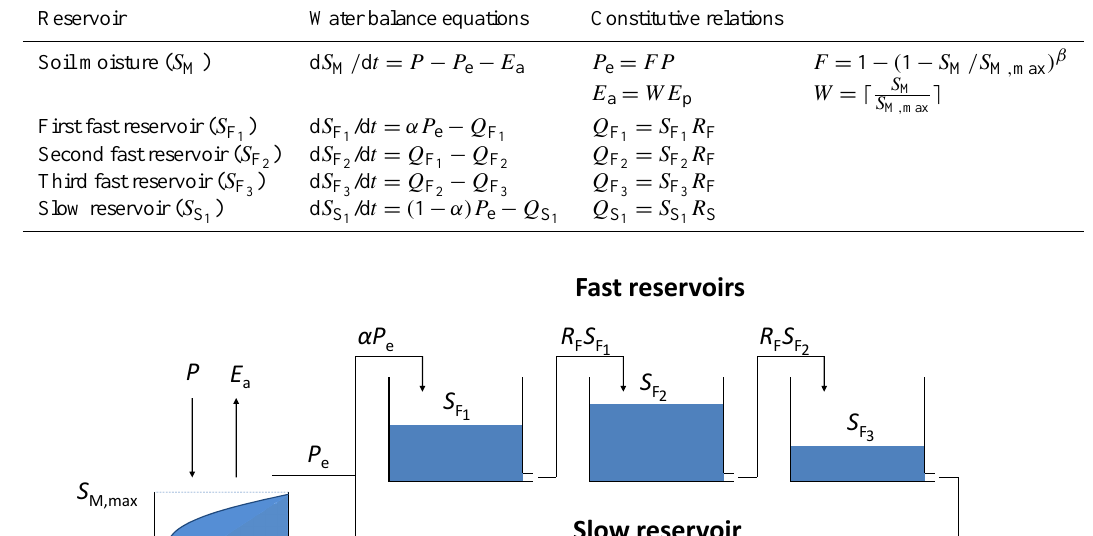
Table 2. Equations used in HyMod.